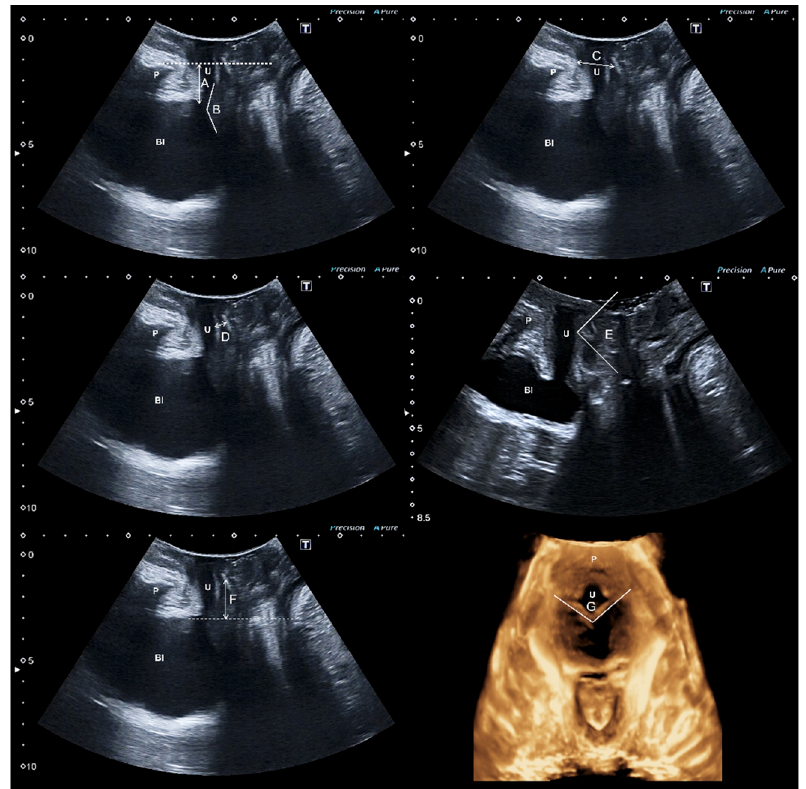
Figure 1. The ultrasound parameters included were the following: bladder neck–symphysis distance (A), posterior urethro–vesical angle (B), the pubic symphysis–tape gap (C), tape–urethral lumen distance (D), sagital tape angle (E), tape position (F), axial tape angle (G)m pubis (P), bladder (Bl), and urethra (U).